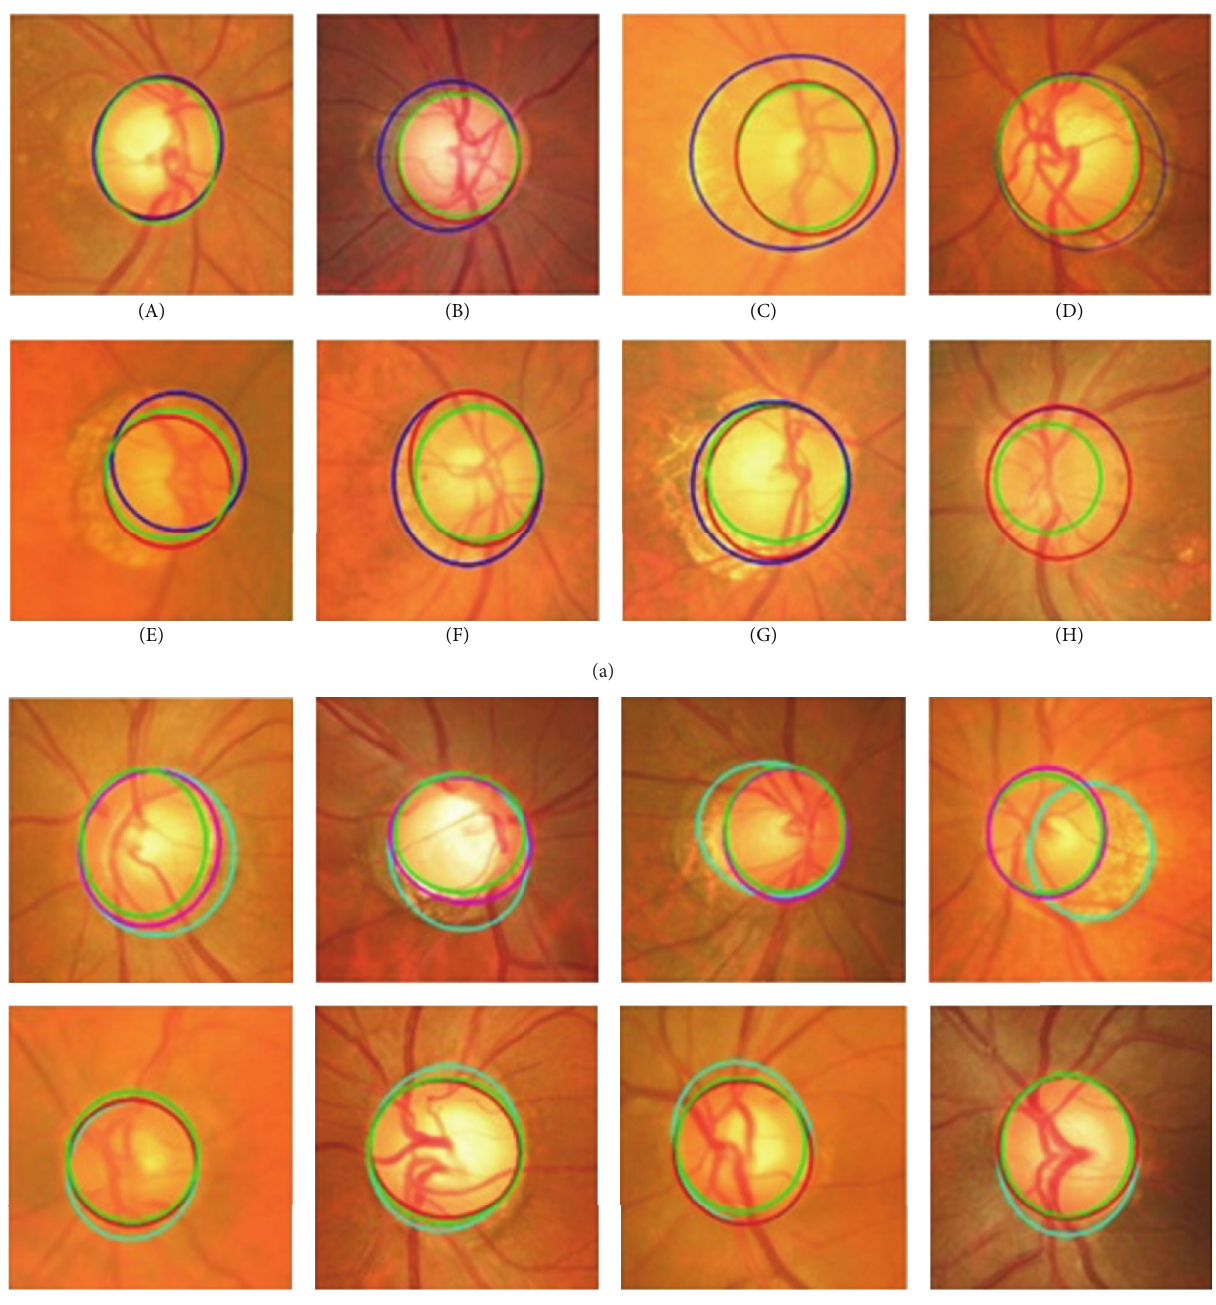
Figure 16: (a) The results (blue: without EF, red: with EF, and green: ground truth). (b) The results (cyan: before 𝛽 -PPA detection, magenta: after 𝛽 -PPA detection, red: with ellipse correction, and green: ground